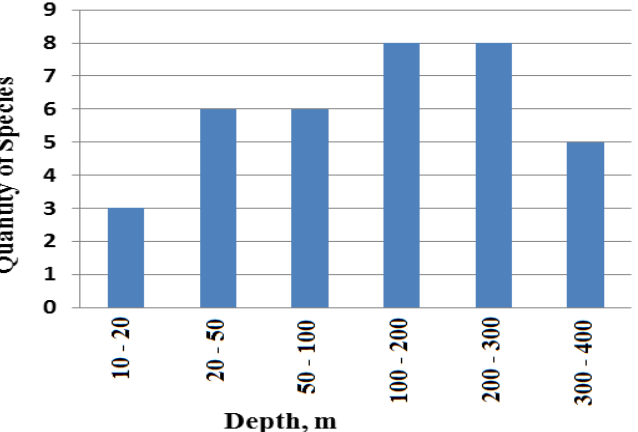
Figure 4. Dynamics of the number of species of zooplankton depending on the depth of the eastern section of the Middle Caspian, May 2016.